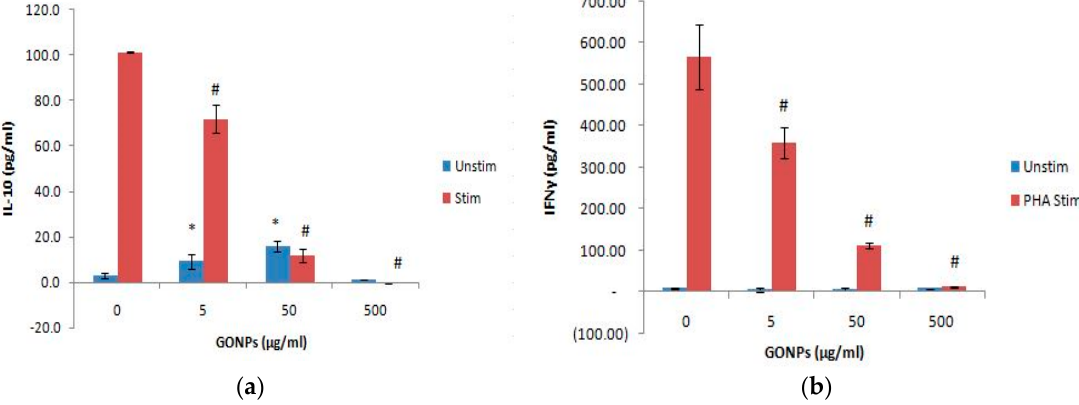
Figure 6. The acquired immune system biomarker expression levels of whole blood cell cultures exposed to GONPs in the absence or presence of PHA: ( a ) IL-10 expression levels and ( b ) IFN γ expression levels. Data represents mean ± SD with n = 4. Bars marked with symbols indicate significant differences ( p < 0.01). Significance demarcated by: *—significantly different compared to negative control ( p < 0.001), # —significantly different compared to positive control ( p < 0.001).